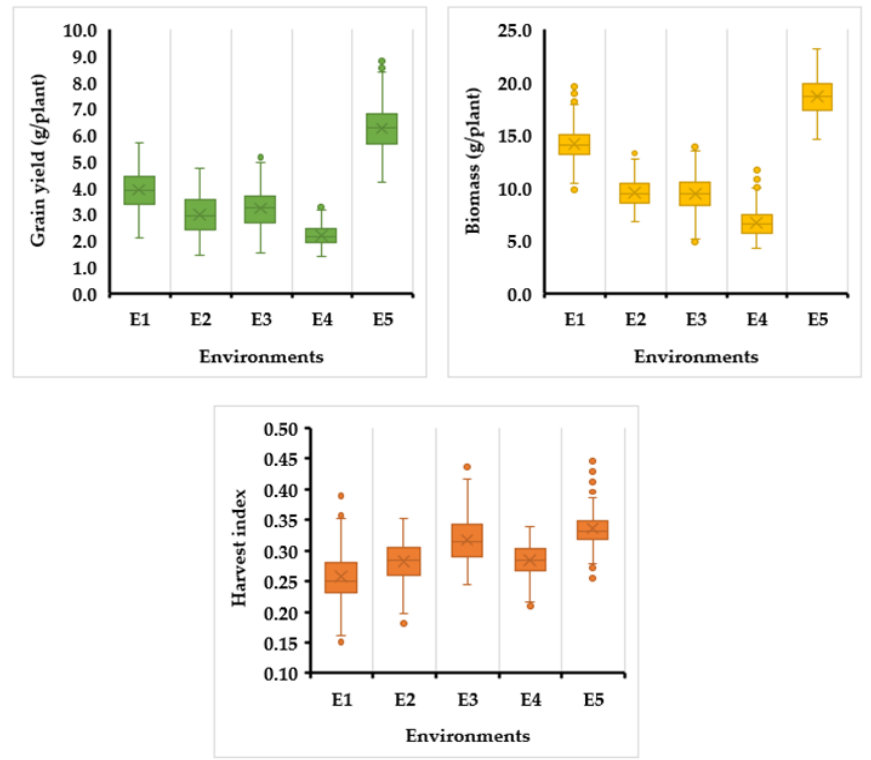
Figure 2. Genotype performance across the test environments for grain yield, biomass, and harvest index based on BLUP-adjusted mean values. E1 = Adet 2018, E2 = Adet 2019, E3 = Bichena 2018, and E4 = Bichena 2019. E5 refers the intensive growing condition and the data were analyzed sepa- rately.